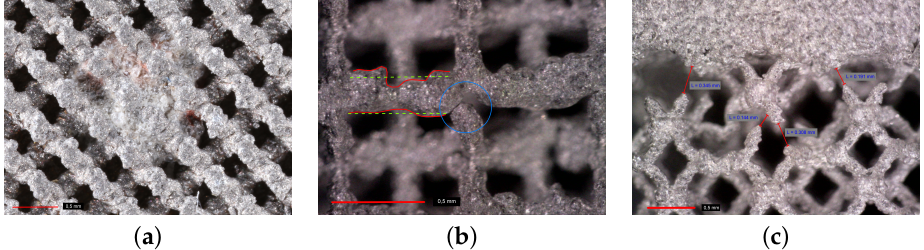
Figure 4. Defects of trabecular specimens: ( a ) clusters of slag inside trabecular structure, ( b ) disconti- nuities within trabecular structure and variability in strut thickness, ( c ) discontinuities (debonding) at interface between trabecular and homogeneous part (photographs provided by high-resolution camera Canon 6D Mark